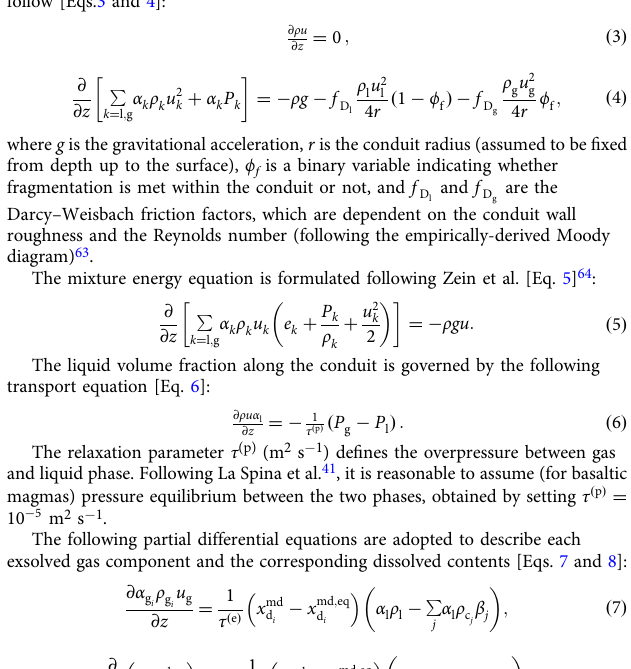
Fig. 7 Comparison of the numerical solutions for the reference and external volatile simulations. Evolution of ( a ) pressure, ( b ) exsolved gas volume fraction, ( c ) mixture velocity, and ( d ) mass eruption rate along the conduit obtained for the Etna 122 BCE reference case (blue solid lines) and for the external H 2 O (green solid lines) and CO 2 (cyan dashed lines) cases. Compared to the fi rst set of simulations, an increase in volatile content of 1 wt.% due to the interaction with an external volatile source results in magma chamber pressurisation and expansion, and ultimately in an increase in